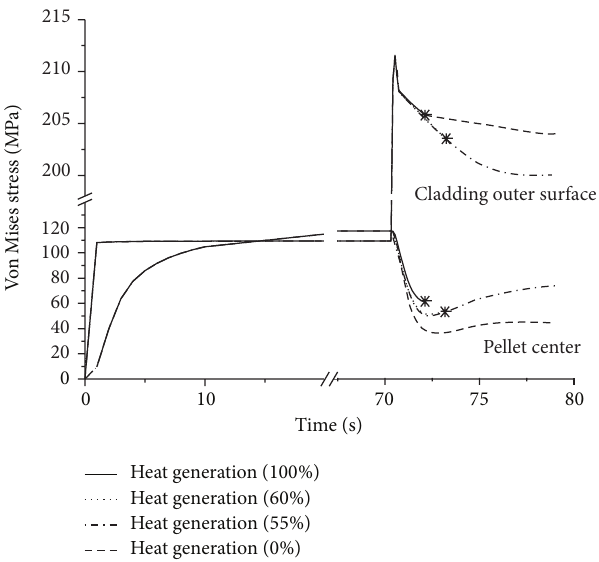
Figure 11: Von Mises stresses changes at pellet center and cladding outer surface after LOCA at 70 sec.